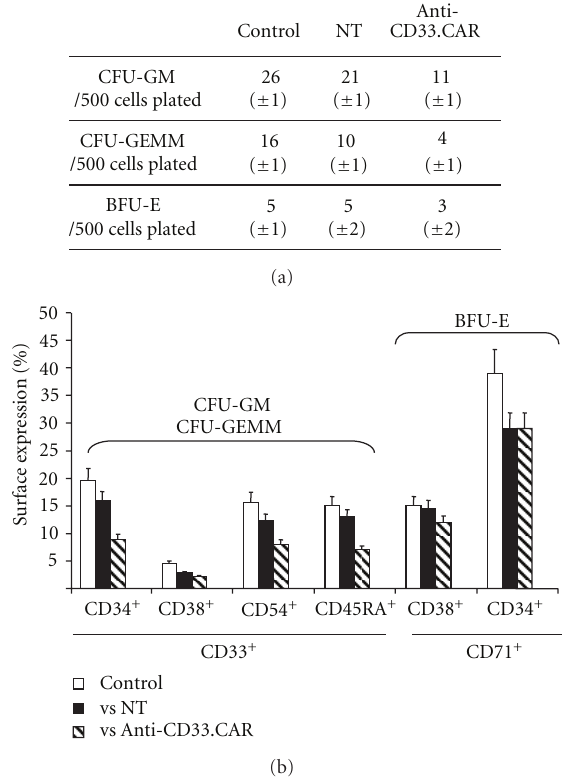
Figure 4: Cytotoxicity of anti-CD33.CAR-transduced EBV-CTLs against normal myeloid progenitors. (a) Unmanipulated or anti- CD33.CAR-transduced EBV-CTLs were incubated with bone- marrow-derived CD34 + progenitors at E:T ratio of 1: 1 for 4 hours. Cells were then seeded in methylcellulose-based medium and after 10 days CFU-GM, CFU-GEMM, and BFU-E were counted. Data shown are mean ± SD of 6 independent experiments. (b) Colonies were collected and characterized by flow cytometry to assess the expression of surface markers specific for each colony type. Data shown are mean ± SD of 6 independent experiments.